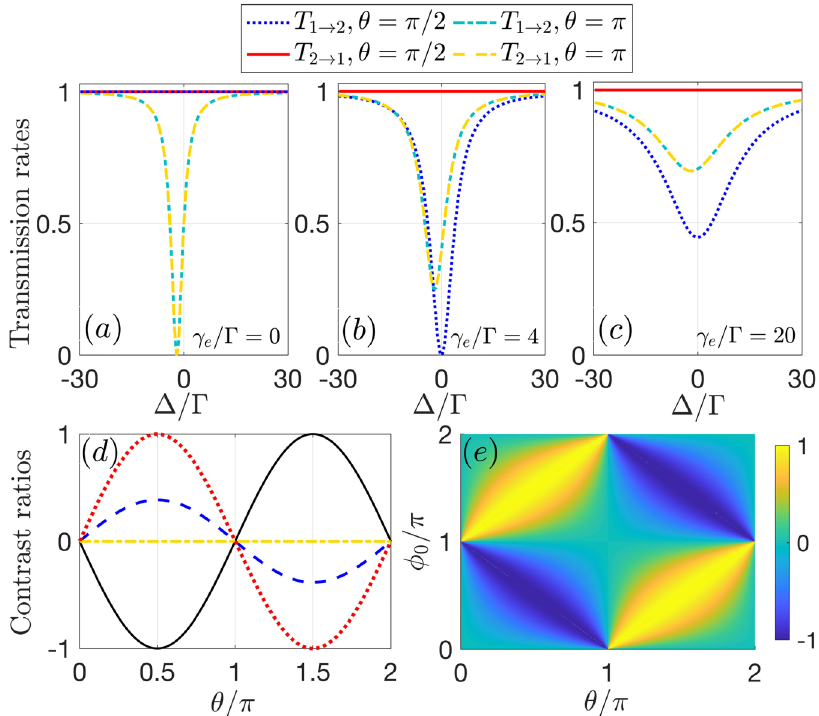
Fig. 3 The in fl uence of the coupling phase difference and accumulated phase on transmission rates and contrast ratios. Transmission rates T 1 → 2 and T 2 → 1 versus the detuning Δ with accumulated phase ϕ 0 = π /2 and different atomic dissipation rates a γ e / Γ = 0; b γ e / Γ = 4; c γ e / Γ = 20, where Γ is the atomic emission rate into the waveguide. d Contrast ratios I and D versus the coupling phase difference θ with ϕ 0 = π /2 and Δ = 0. The yellow dot-dashed, red dotted, and blue dashed lines are I with γ e / Γ = 0, γ e / Γ = 4, and γ e / Γ = 20, respectively, and the black solid one represents D independent of γ e . e Contrast ratio D versus θ and ϕ 0 with Δ = 0. Other parameters: photon propagation time τ Γ =